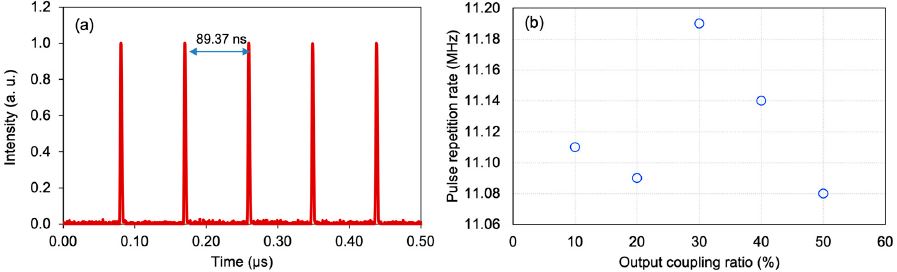
Figure 9. Pulse repetition rate of EDFL with GNP-SA; ( a ) oscilloscope trace of the output pulse for 30% and ( b ) different output coupling ratio values.